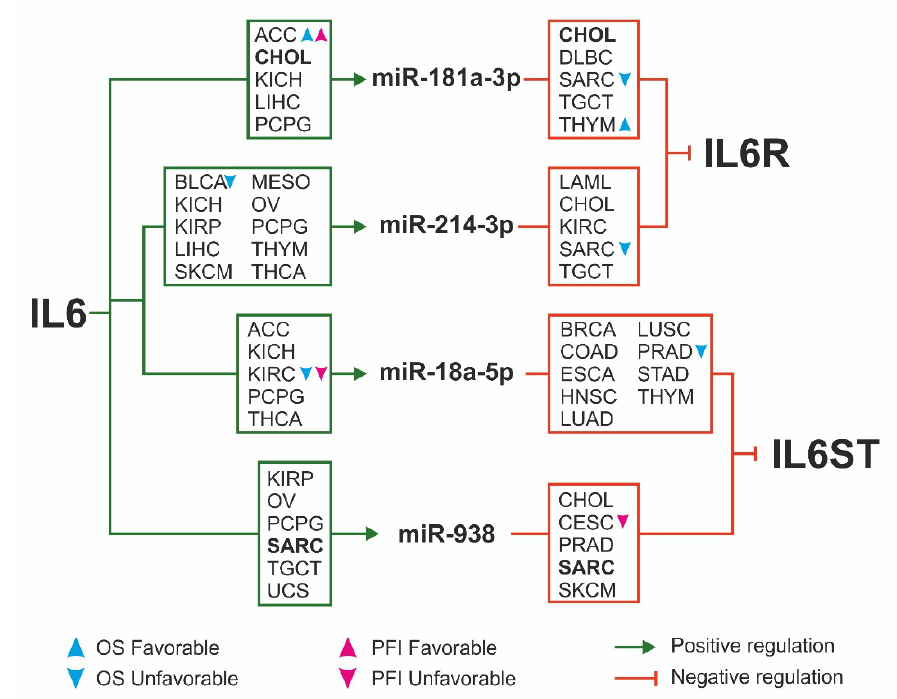
Figure 7. Negative feedback on IL6 receptors mediated by IL6-dependent miRNAs. The miRNAs positively correlated with IL6 and negatively correlated with IL6R and IL6ST in at least 5 different tumors are shown. In boxes are listed the tumor types showing miRNAs positively correlated with IL6 (green boxes) and negatively correlated with IL6R and IL6ST (red boxes). The tumors in which both correlations are satisfied are highlighted in bold. The prognostic significance of selected miRNAs for each tumor is indicated by the blue (OS) and magenta (PFI) arrowhead. Abbreviations: ACC: Adrenocortical Cancer; BLCA: Bladder Cancer; BRCA: Breast Cancer; CESC: Cervical Cancer; CHOL: Bile Duct Cancer; COAD: Colon Cancer; DLBC: Large B(-)cell Lymphoma; ESCA: Esophageal Cancer; HNSC: Head and Neck Cancer; KICH: Kidney Chromophobe; KIRC: Kidney Clear Cell Carcinoma; KIRP: Kidney Papillary Cell Carcinoma; LAML: Acute Myeloid Leukemia; LIHC: Liver Cancer; LUAD: Lung Adenocarcinoma; LUSC: Lung Squamous Cell Carcinoma; MESO: Mesothelioma; OV: Ovarian Cancer; PCPG: Pheochromocytoma and Paraganglioma; PRAD: Prostate Cancer; SARC: Sarcoma; SKCM: Melanoma; STAD: Stomach Cancer; TGCT: Testicular Cancer; THCA: Thyroid Cancer; THYM: Thymoma; UCS: Uterine Carcinosarcoma.